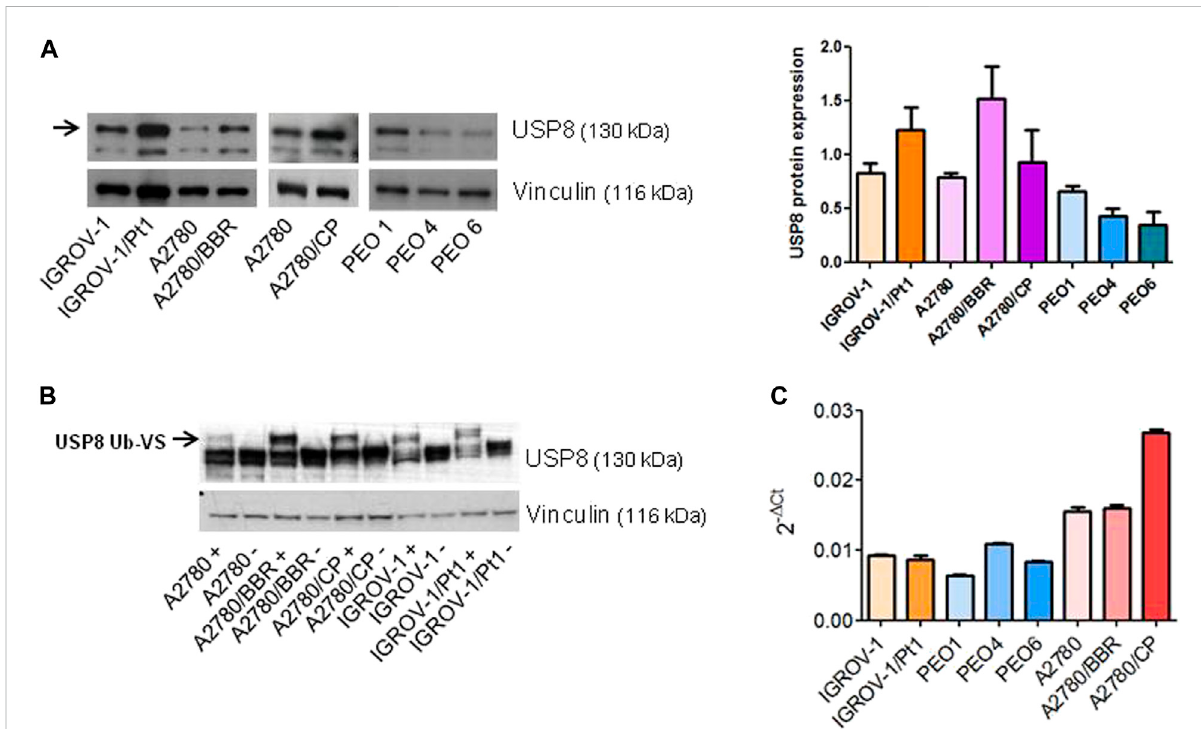
FIGURE 1 USP8levelsandactivityindifferentovariancarcinomacelllines. (A) Western blotanalysisofUSP8expressionindifferentovarian carcinomacell lines, IGROV-1, A2780, PEO1 and the resistant variants. Vinculin was used as loading control. One experiment representative of at least three is reported. Band intensity was quanti fi ed using ImageJ and normalized to vinculin. The obtained values are reported in the histogram on the right. (B) USP8activityinovariancarcinomacelllines,IGROV-1,A2780andtheresistantvariants.Labelingofdeubiquitinasesfromwhole-celllysateswith HA-Ub-VS was followed by electrophoresis and immunoblotting with USP8. +, samples incubated with HA-Ub-VS; -, samples incubated without HA-Ub-VS. Control loading is shown by vinculin. The blot is overexposed to allow detection of the active band (indicated by the arrow). One experiment representative of at least three is reported. (C) Analysis of USP8 mRNA levels by qRT-PCR. GAPDH was used as housekeeping